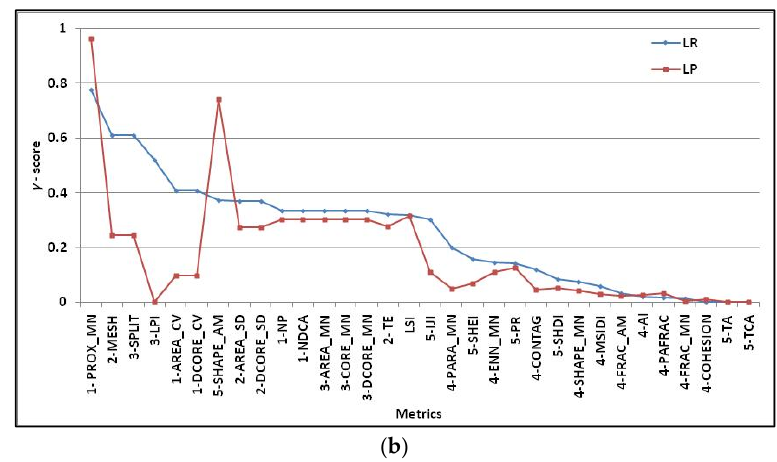
Figure 4. β -scores ( a ) and γ -scores ( b ), respectively, comparing the relative magnitude of each landscape metric in two contrasting provinces ranked in descending order for each of five change years (number before metric indicates cluster number, see Section 4.1). (See Table 1 for details of each metric). Most of the metrics that discriminated well between the two provinces belonged to clusters 2, 3 and 5, while the metrics in cluster 4 were characterized by low β -scores. However, the behavior of the metrics was not uniform in all change periods. That is, if a metric highlighted difference in values in the 1972–1987 period, the same metric did not necessarily highlight a difference in other change periods. A subset of selected metrics showed uniform differences in all change periods between the two landscapes (e.g., LPI , SHAPE_AM , AREA_MN , DCORE-SD , PR and SHEI ) while the remaining metrics highlighted differences in only selected periods. For example, PROX-MIN showed a difference in 1972–1987 but not other periods. Similarly, TE did not highlight a difference in 1972–1987 and